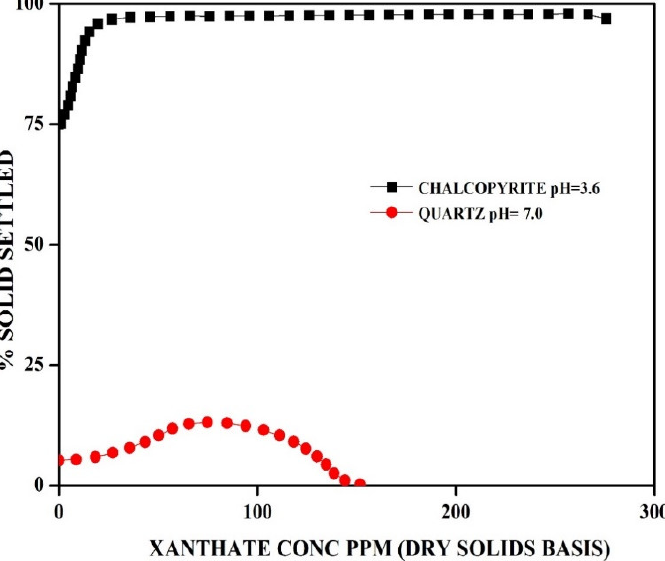
Figure 8. Percentage of chalcopyrite and quartz settled as a function of the concentration of hydrox- ypropyl cellulose xanthate [47].